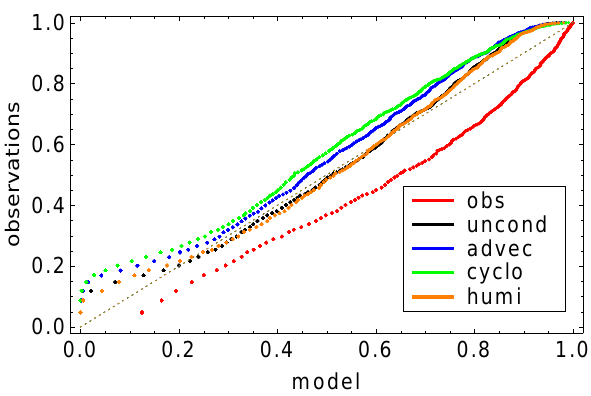
Fig. 12. Empirical CDF of observed precipitation in Garmisch-Partenkirchen, conditioned on the occur-